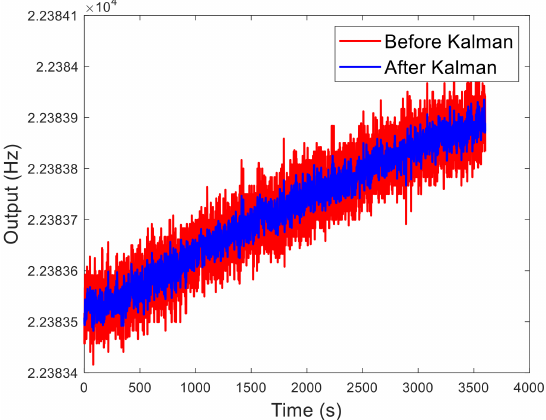
Figure 11. Influence of Kalman filter on signal